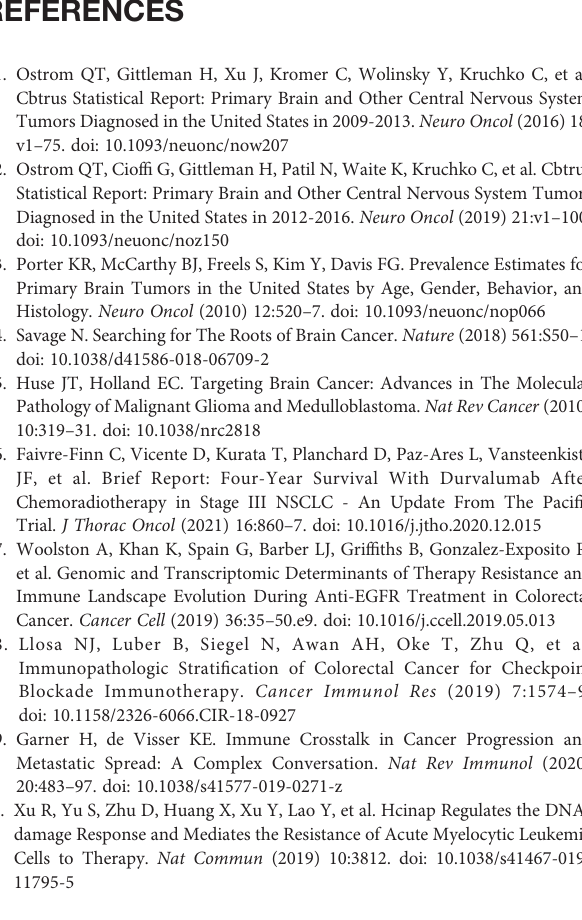
Supplementary Figure 5 | Univariate and multivariate Cox analysis of prognostic risk scores for gliomas. Univariate Cox regression analysis. Forest plot of associations between risk factors and the survival of gliomas in the TCGA (A) , and CGGA (B) . Multiple Cox regression analysis. The DDRGs signature is an independent predictor of gliomas in the TCGA (C) , and CGGA (D) . TCGA, The Cancer Genome Atlas; CGGA, Chinese Glioma Genome Atlas. Supplementary Figure 6 | Prediction of outcome of the DDRGs signature in strati fi ed patients in TCGA dataset. Survival analysis of the signature in patients strati fi ed by age (A, B) , gender (C, D) , grade (E, F) , IDH (G, H) , and 1p19q status (I, J) . DDRGs, DNA damage repair genes; TCGA, The Cancer Genome Atlas; IDH, isocitrate dehydrogenase. Supplementary Figure 7 | Comparison of risk scores in GBM and LGG in the TCGA (A) , CGGA (B) , and GSE4290 (C) . TCGA, The Cancer Genome Atlas; CGGA, Chinese Glioma Genome Atlas. Supplementary Figure 8 | Relationship between the DDRGs signature and immune in fi ltrating cells in the tumor microenvironment. (A) CIBERSORT was used to analyze the types and proportion of in fi ltrating immune cells in the tumor microenvironment of patients with glioma. (B) Differences in immune in fi ltrating cells between high- and low-risk groups determined by CIBERSORT. (C, D) Differences in immune in fi ltrating cells and immune related pathways between high- and low-risk groups determined by ssGSEA. (E) Violin diagram showing the relationship between immune grouping and risk score. DDRGs, DNA damage repair genes; ssGSEA, single-sample gene set enrichment